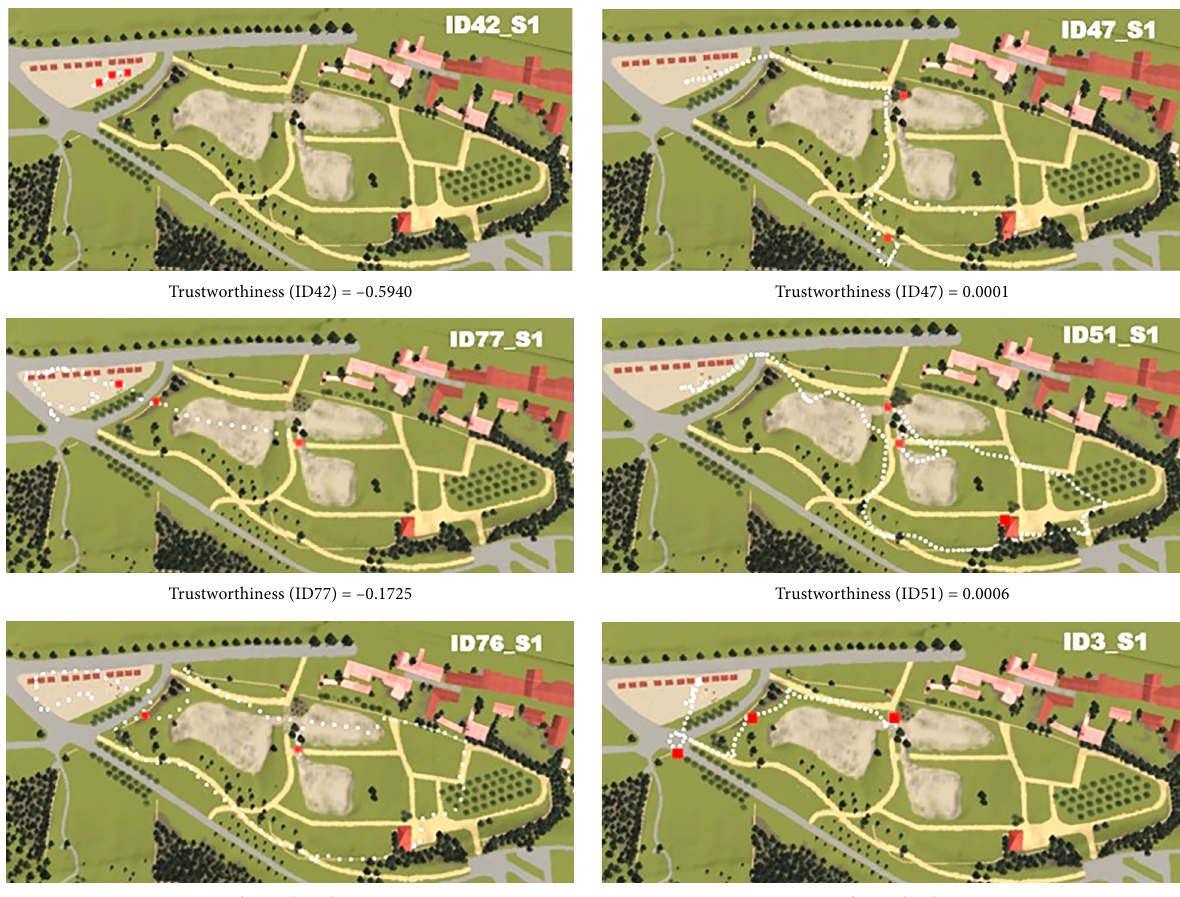
Figure 6. The behaviour of the selected respondents that played Scenario 1 in the gamified survey